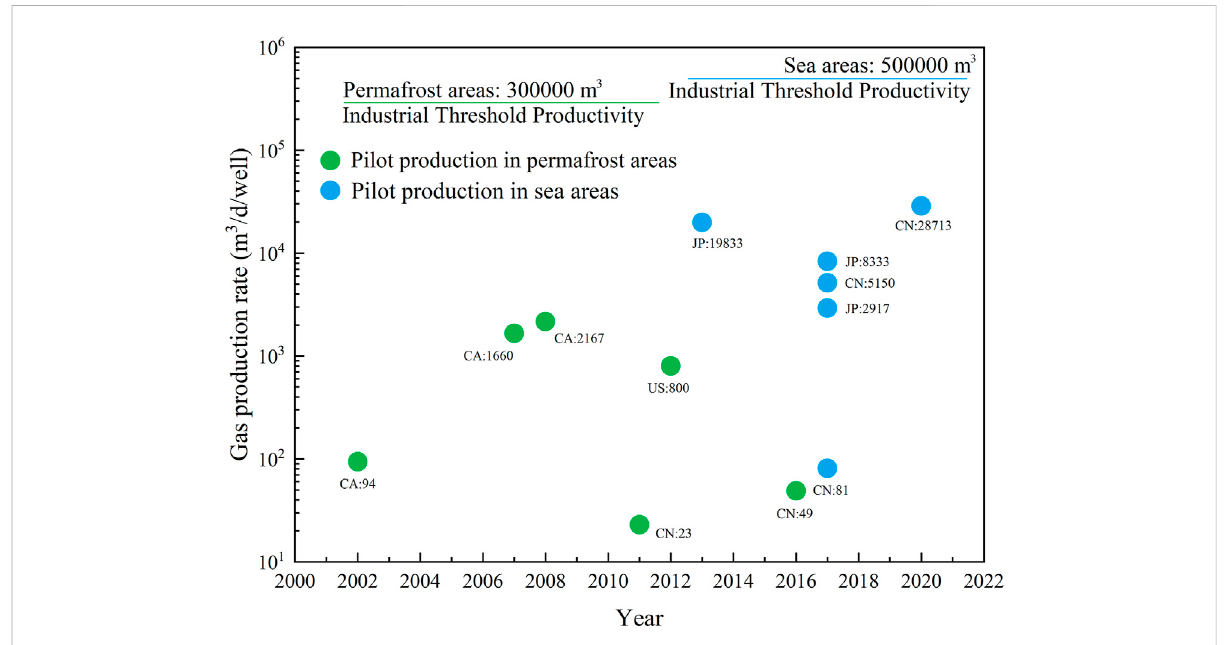
FIGURE 3 Thedailyproductioncapacityofgashydratepilotproductionhasnotyetcrossedtheindustrializationthreshold(modi fi edfrom(Wuetal.,2021; Chen et al.,